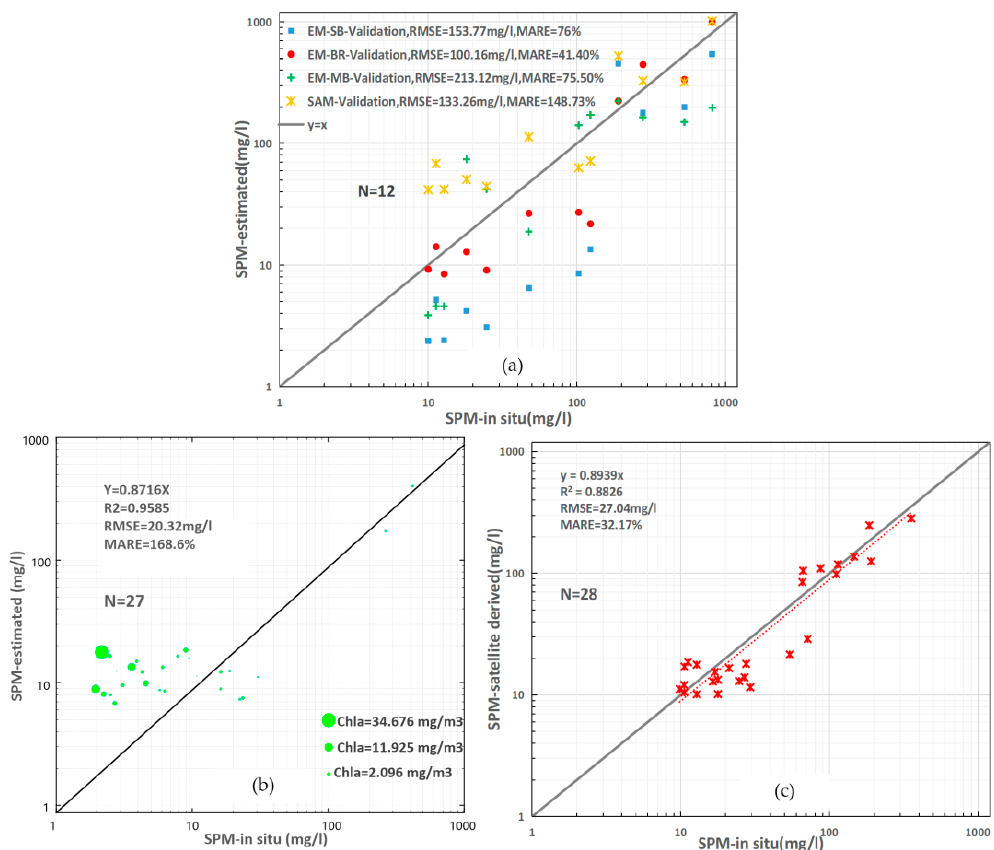
Figure 5 . ( a ) Scatter plots of field measured vs. estimated SPM for the four kinds of algorithms with the field validation data. The EM-BR represents the retrieval model used in this manuscript. ( b ) Scatter plots of field measured vs estimated SPM with validation dataset measured during July 2018 cruise. The size represents chlorophyll-a concentration of each sample. ( c ) Validation results of applying the GOCI-derived R rs in SPM retrieval model.